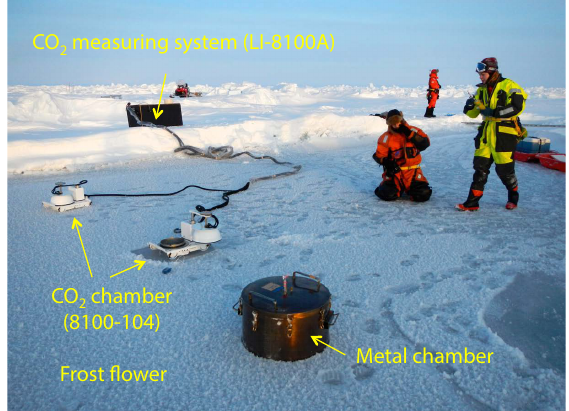
Figure 2. Photographs of the CO 2 flux chamber system at station YI1 north of Svalbard on 13 March 2015. CO 2 flux chamber was installed over the frost flowers on the new thin ice in the refreezing lead. ter removing the snow or frost flowers. Flux measurements were begun immediately in order to minimize the changes of the ice surface condition. In order to evaluate the effect of removing snow on the ice surface temperature, temperature was monitored during CO 2 flux measurements at station FI6. A temperature sensor (RTR 52, T & D Corp., Japan) was in- stalled in the top of the ice (1 cm) surface after snow removal. During the first CO 2 flux measurements (about 30 min), the ice surface temperature was stable at − 5.8 ◦ C, suggesting that the effect of removing snow on the variation of sea ice surface temperature was negligible within 30 min. The ice surface temperature decreased from − 5.8 to − 8.0 ◦ C at 200 min after removal of snow. Therefore, in this paper, the data of the initial 30 min of CO 2 flux measurement after re- moval of snow or frost flowers were used. The chamber was closed for 20 min in a sequence. The 20 min time period